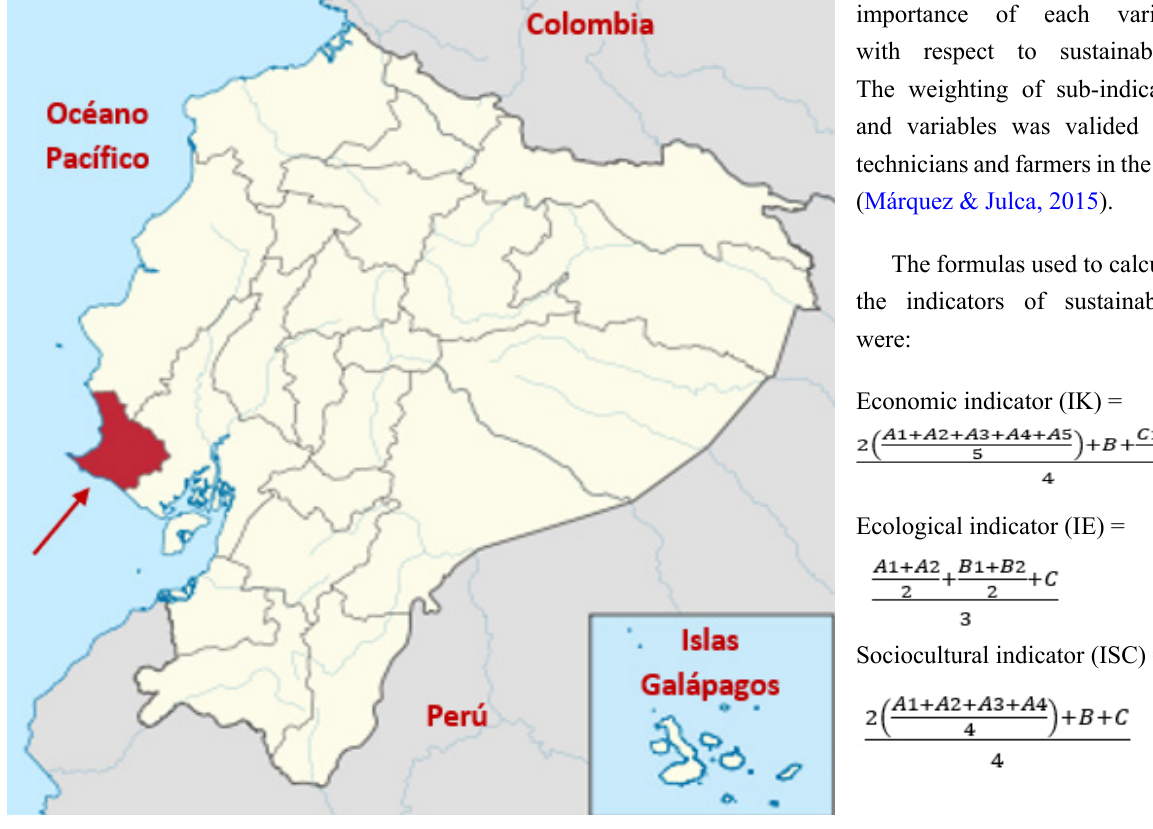
Figure 1. Location of the Province of Santa Elena in